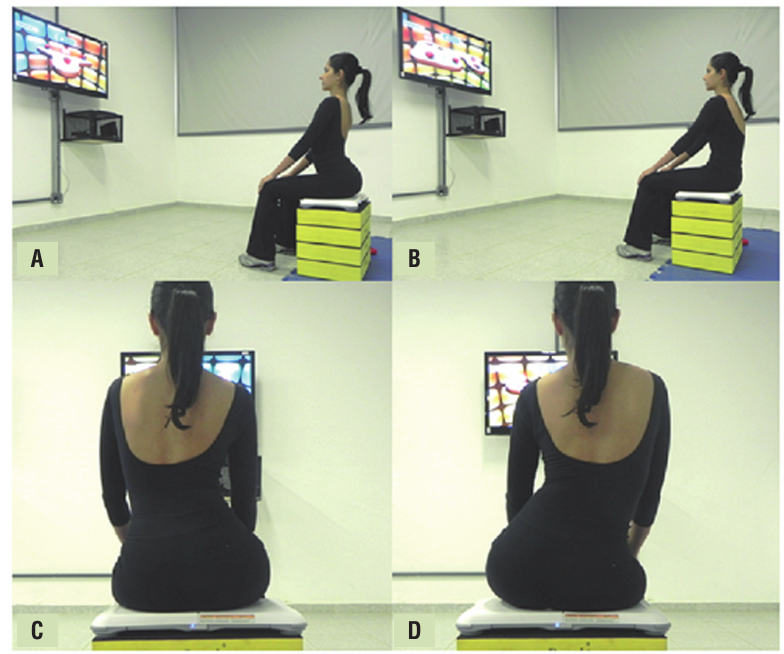
figure 1 - Movements are performed over the platform, during virtual games.